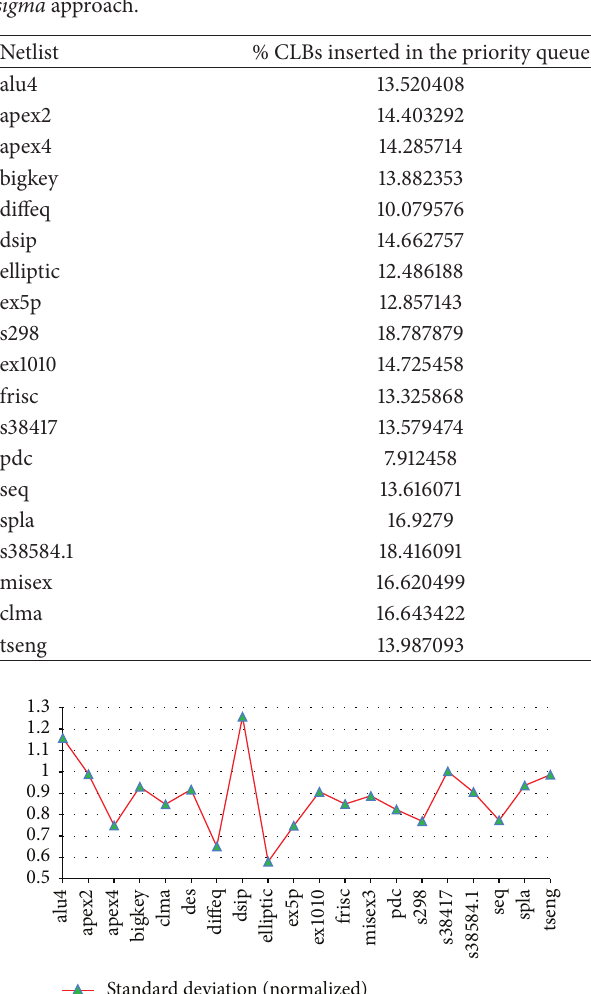
Table 4: Percentage of CLBs inserted in the priority queue for 1- sigma approach.